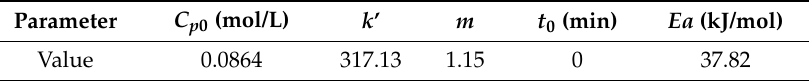
Table 2. The values of the parameters from curve fitting.